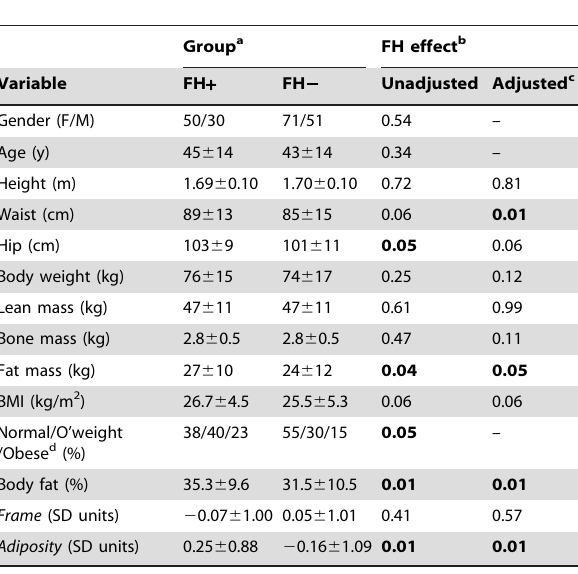
anthropometric and body composition